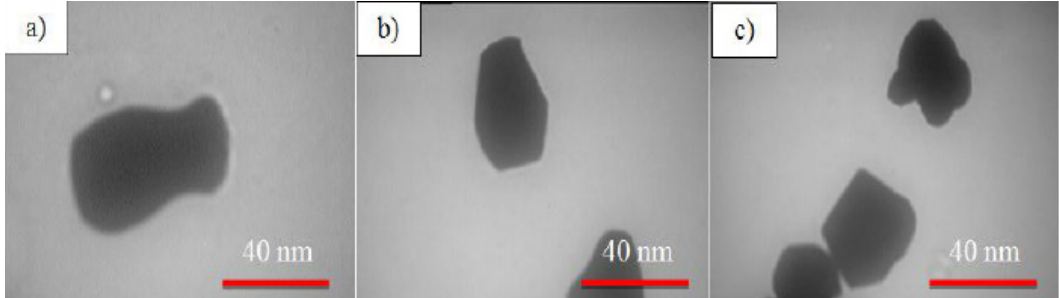
Fig. 2. TEM micrographs of the synthesized akermanite nanopowder milled for 6h (a), 8h (b), and 10h